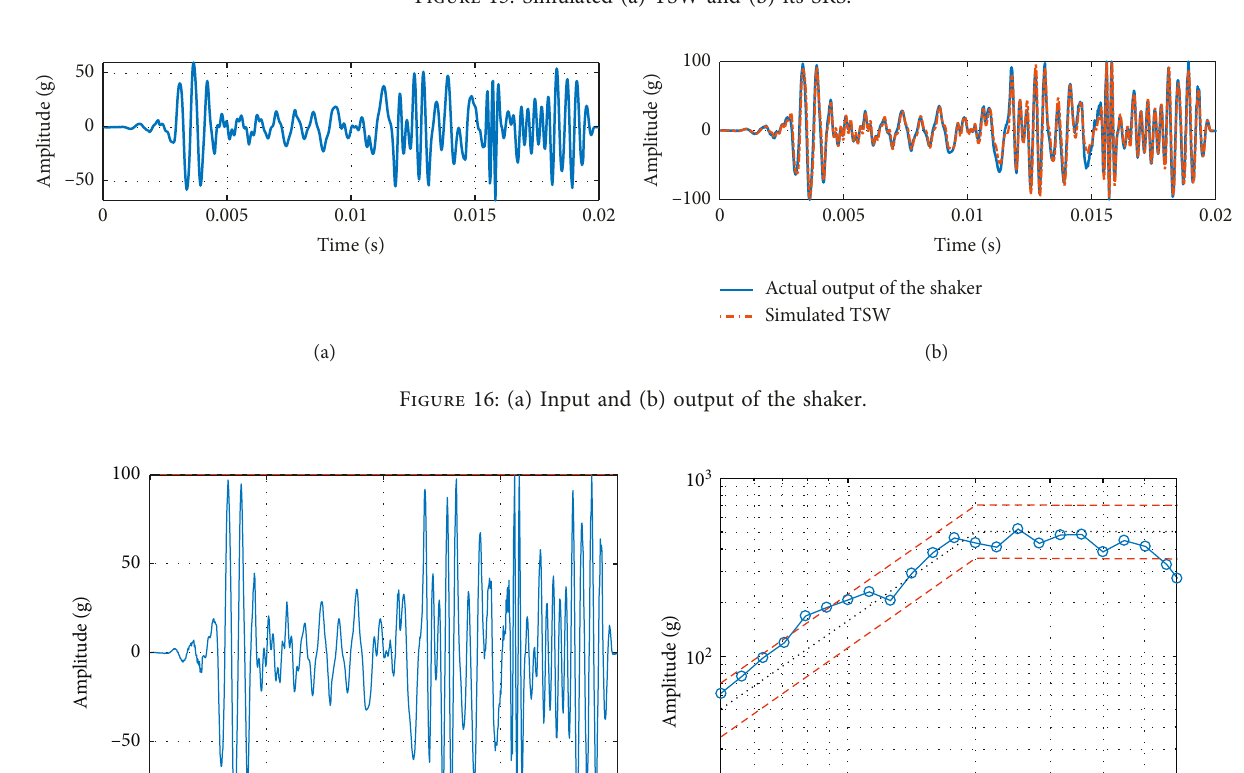
Figure 15: Simulated (a) TSW and (b) its